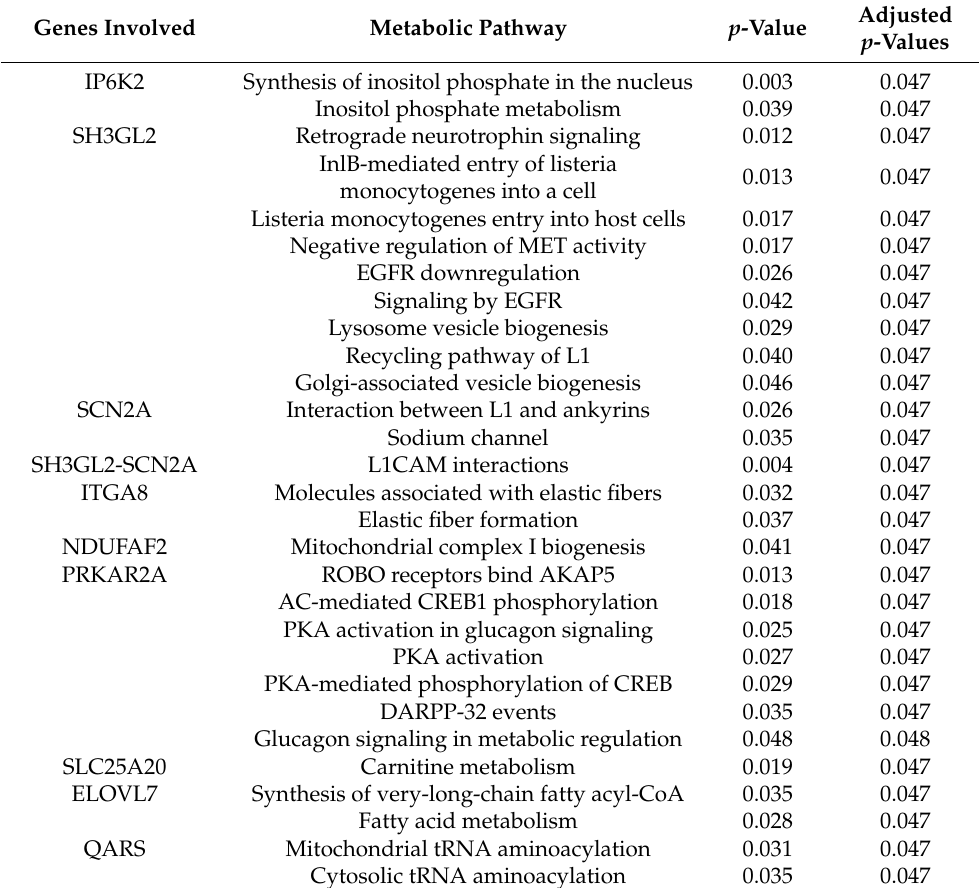
Table 6. Enrichment analysis of SNPs associated with NOH. Genes